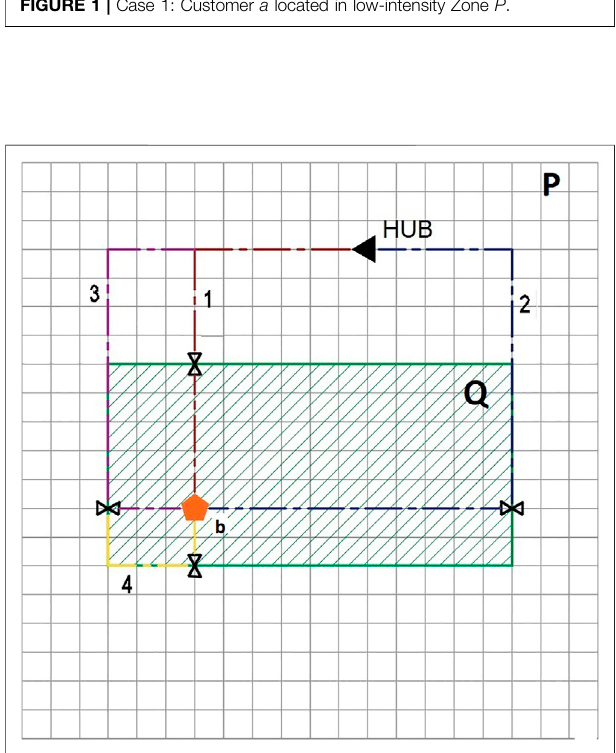
FIGURE 2 | Case 2: Customer b located in high-intensity Zone Q